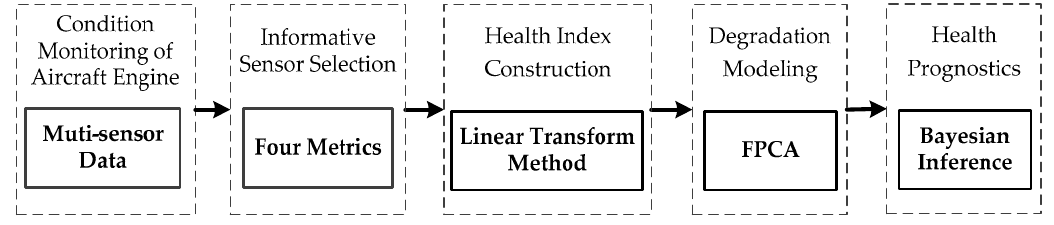
Figure 1. Flowchart of the proposed method. Abbreviations: FPCA, functional principal component.